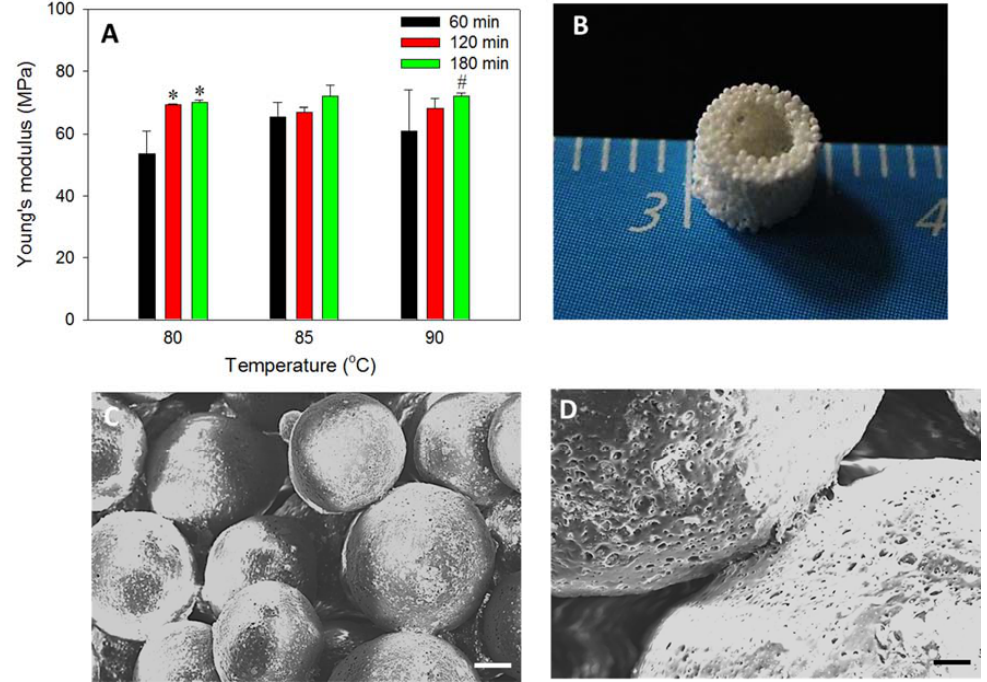
Figure 3. ( A ) Mechanical strength of the cavity ‐ shaped microsphere scaffolds evaluated through